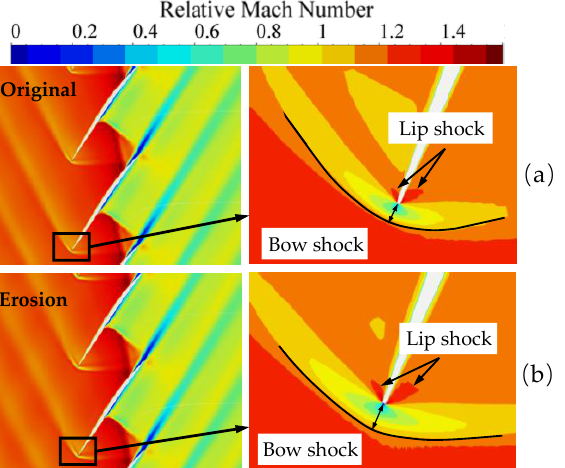
Figure 14. The contour of the Mach number distribution at the leading edge of an ( a ) original blade and ( b ) eroded blade.